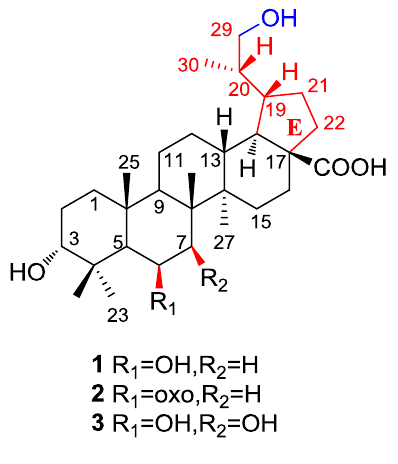
Figure 1. Structures of compounds 1 – 3